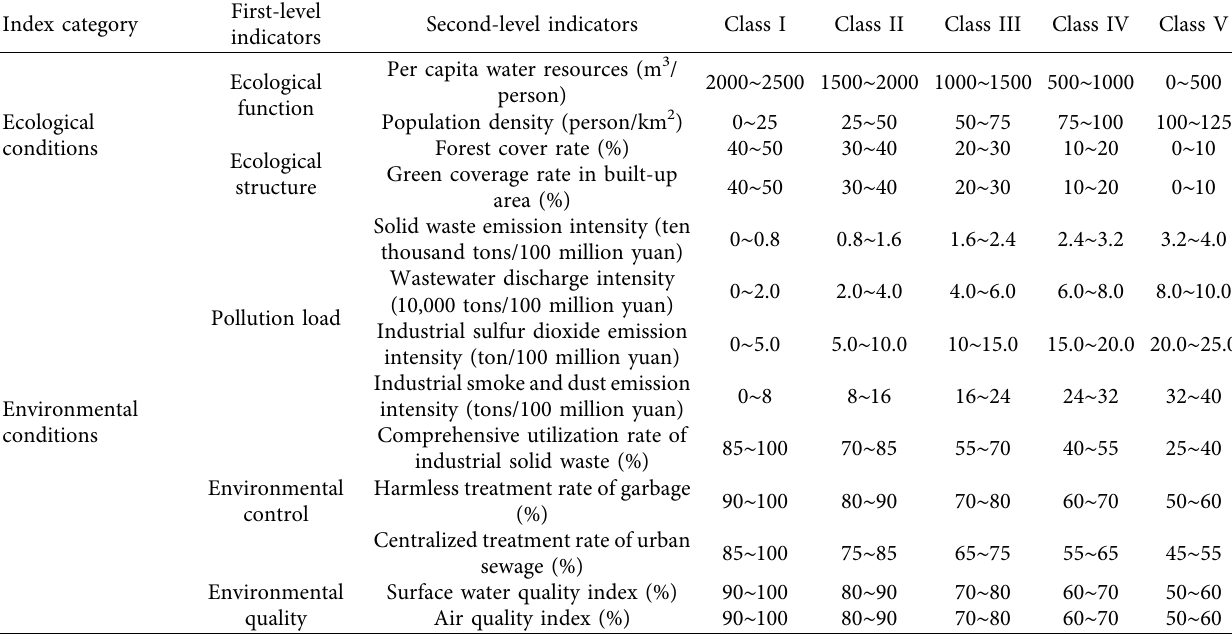
Table 1: Environmental quality evaluation index system and index classification standards of ecological